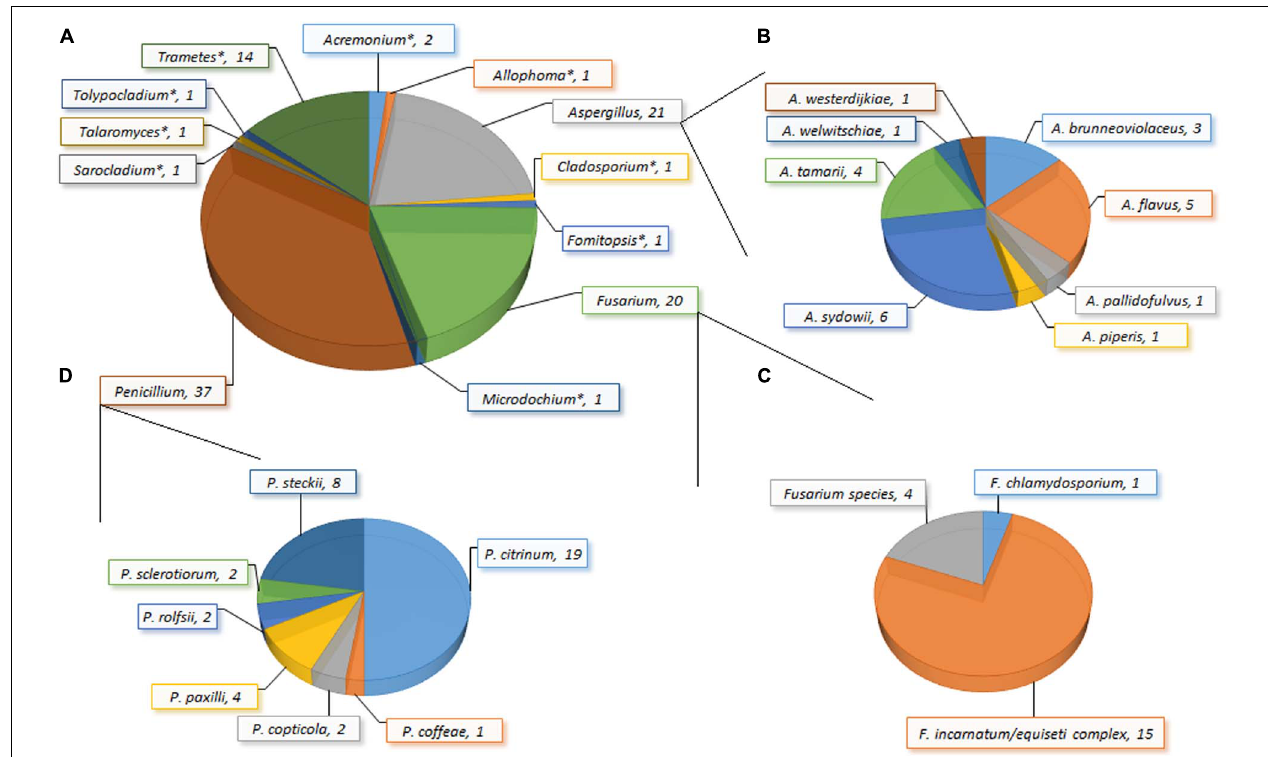
FIGURE 2 | Incidence of fungi (A) : genera; (B) species within Aspergillus ; (C) species within Fusarium ; (D) species within Penicillium ) in garri (farinated cassava) sold in markets in Ogun State, Nigeria. *Only one species of the genus was recovered: Acremonium charticola , Allophoma species, Cladosporium tenuissimum , Fomitopsis meliae/durescens , Microdochium lycopodinum , Sarocladium strictum , Talaromyces siamensis , Tolypocladium species, and Trametes polyzona